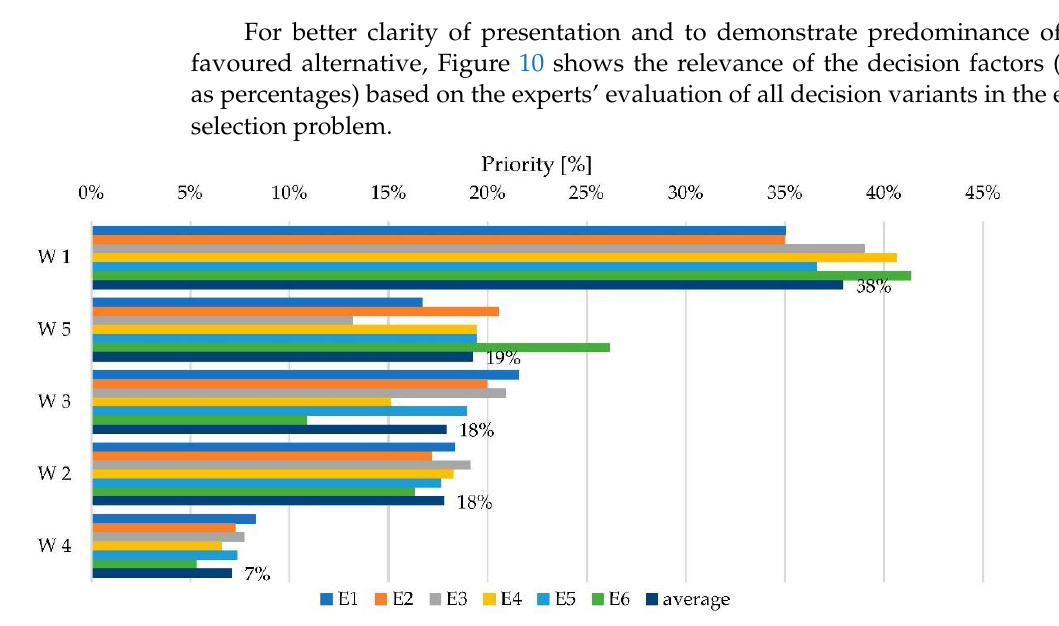
Figure 10. Ranked list of relative priority weights in the analysed decision variants based on experts’ scoring (the outcome of the computation procedure).